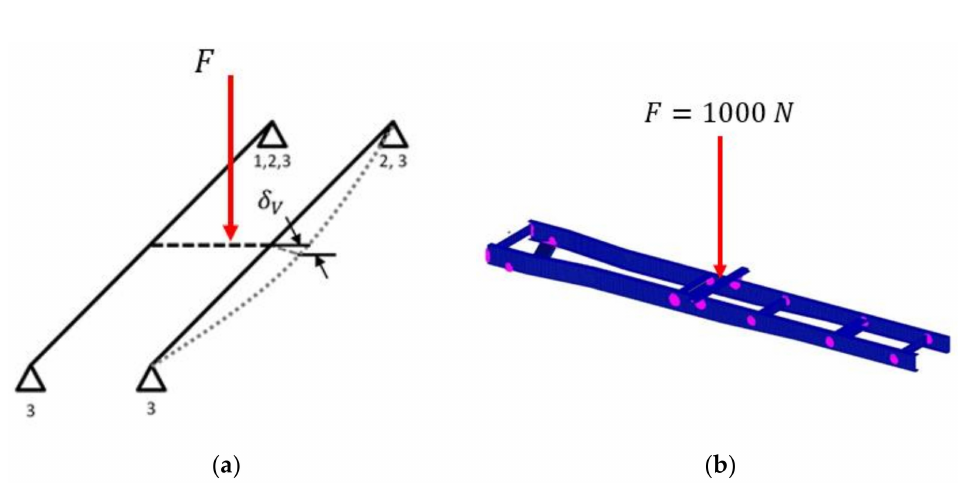
Figure 4. ( a ) Vertical bending deflection under applied load in the middle. ( b ) Finite Element Model with vertically downward force.